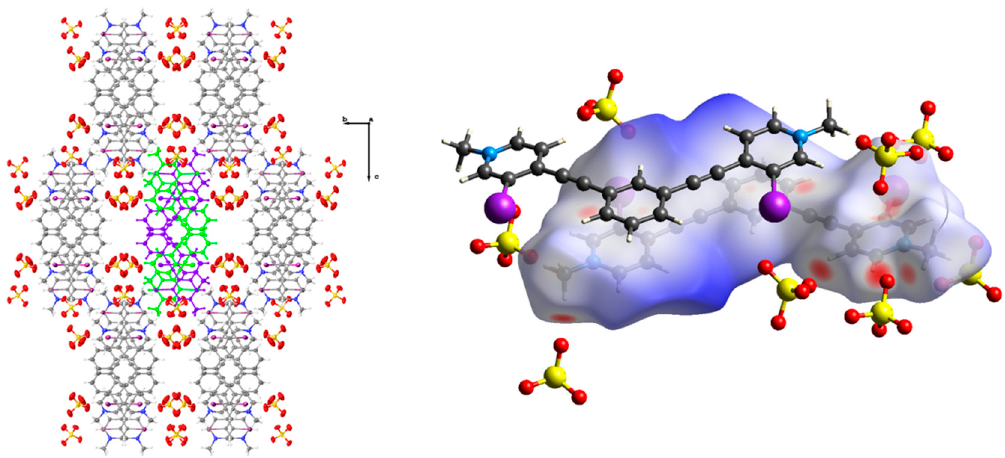
Figure 4. Packing diagram of 2 when viewed down the crystallographic a axis ( left ). Anion disorder omitted for clarity, and thermal ellipsoids are drawn at the 50% probability level. Hirshfeld surface map of 2 highlighting the C-H hydrogen bonding contacts and arrangement of hydrogen sulfate anions around the receptor as well as the off-centered antiparallel dimer ( right ).